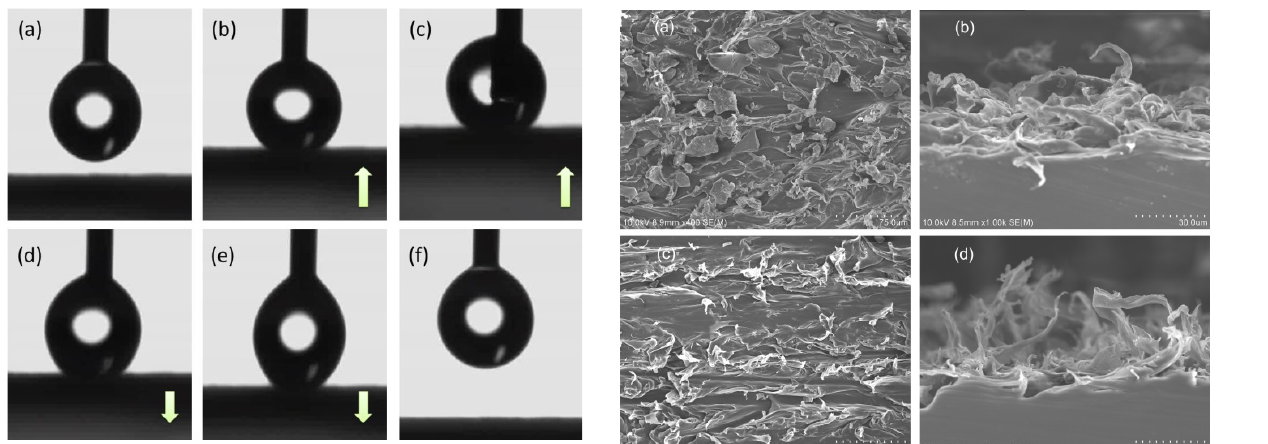
Figure 5 : Superhydrophobic LDPE surface, scraped with P360 abrasive paper and then bonded and peeled, shows low adhesive force. With the ascending of PE substrate, the water droplet suspended on a syringe (a) became contacted with the surface (b) and even deformed (c), and with the descending of PE substrate, the water droplet departed from the lowering surface (d-f). The arrows represent the substrate’s moving direction.